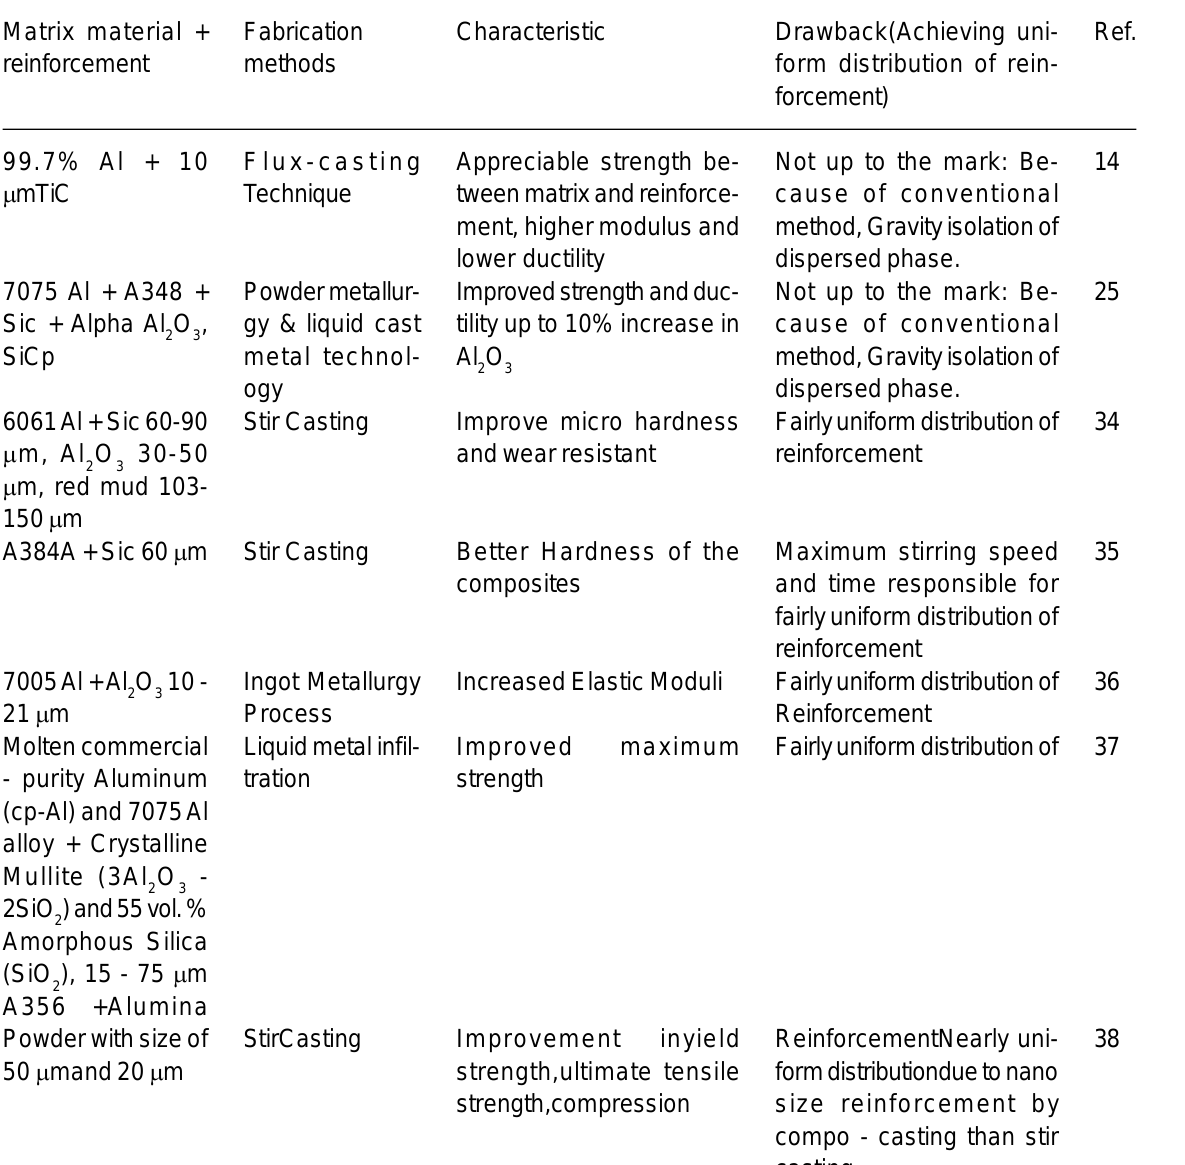
Table 1. Overview of previous research work of processing of AMMC using different techniques and their